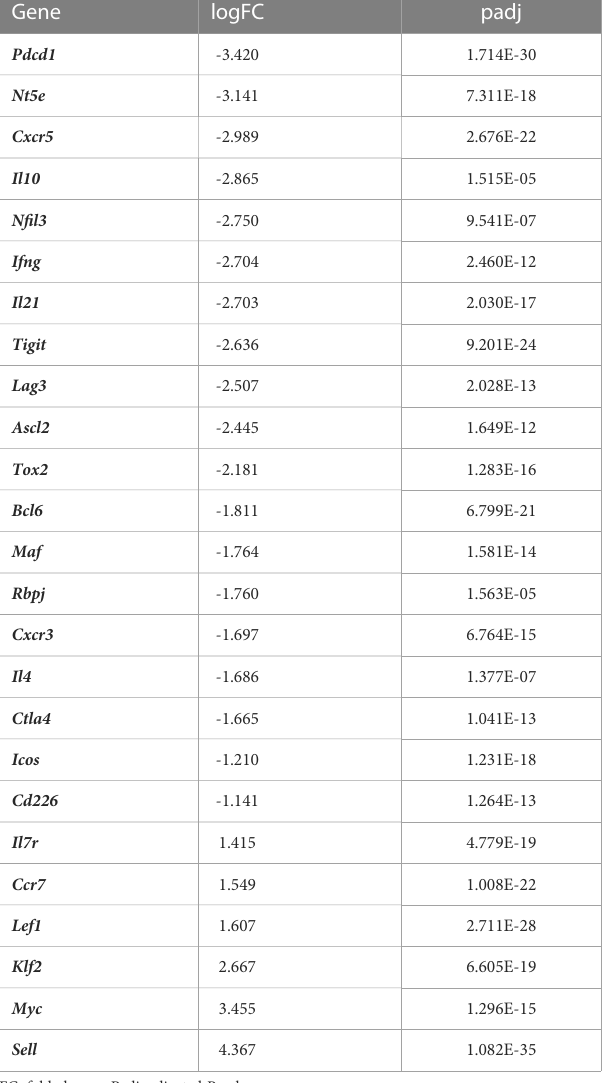
TABLE 1 Differentially expressed genes in tetramer+ vs Tconv